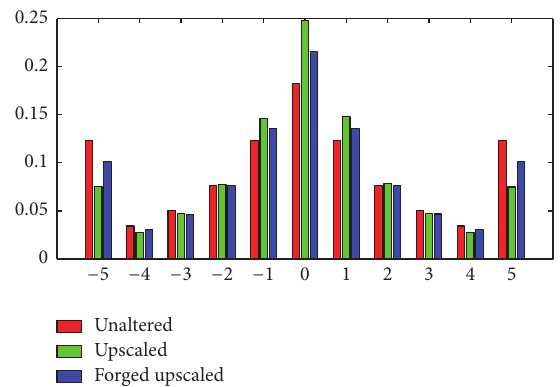
Figure 3: The average histogram for 1500 unaltered images, their corresponding upscaled images ( 𝑠 = 3/2 , bicubic), and forged upscaled images ( attack 1, 𝑠 = 3/2 , 𝜎 = 0.4 , bicubic).